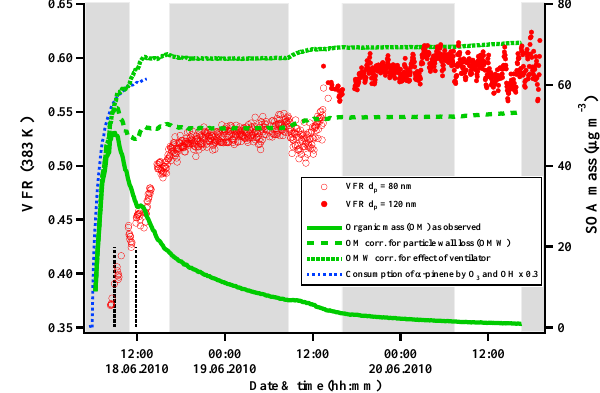
Fig. 4. Comparison of VFR (383K) measured during SOA08-14 ( α -pinene + ozone, with OH ageing) and the calculated SOA mass based on a SOA model using 4 products of different volatility, mod- elled SOA mass without additional OH chemistry. Low volatile (LVOC), semi-volatile (SVOC) and OH-product. The white area indicates ageing with OH-radicals (TME addition).